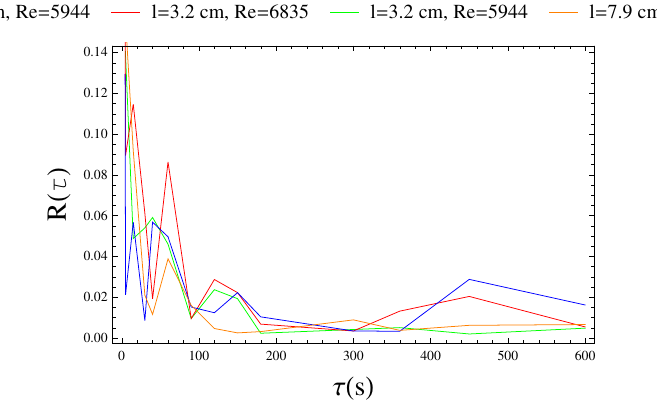
Figure 7. Development of the autocorrelation function over aggregation time for each